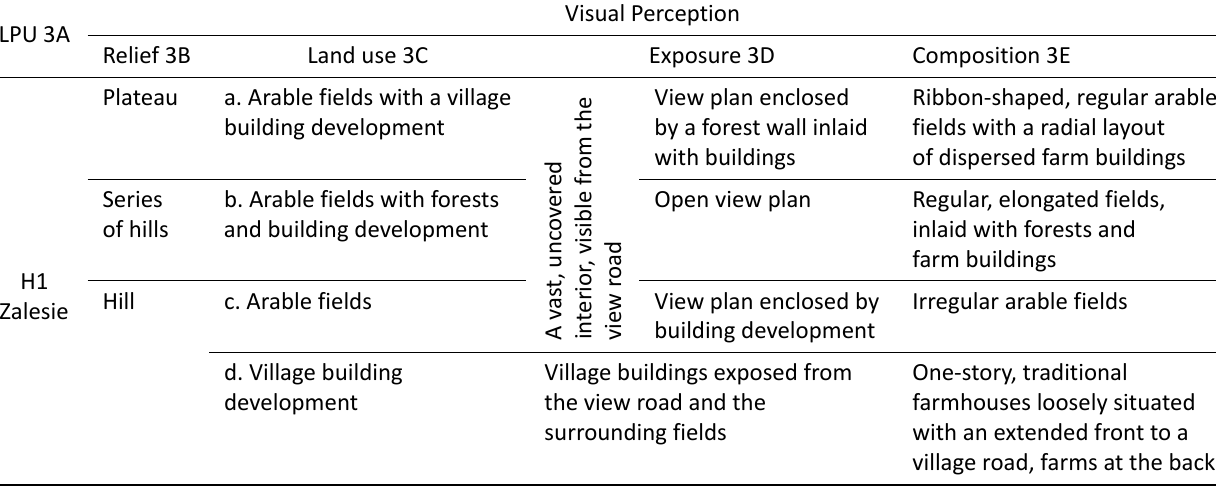
Table 3. Extension of Table 2 regarding the description of landscape exposure and